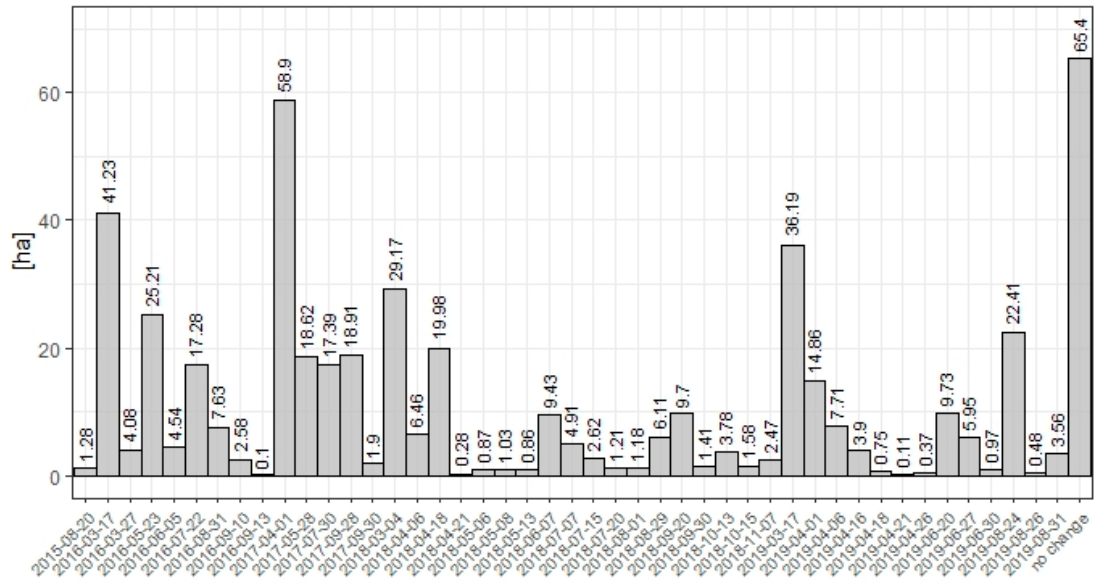
Figure 9. Changes detected in coniferous forests from 2015 to 2019.